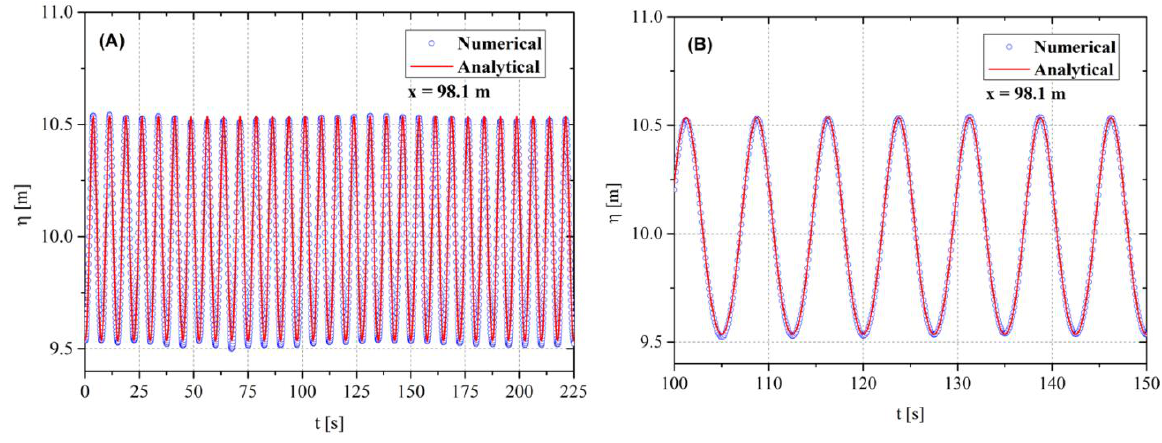
Figure 8. Elevation of the free water surface: ( A ) all simulation times; ( B ) detail of 100 s  t  150